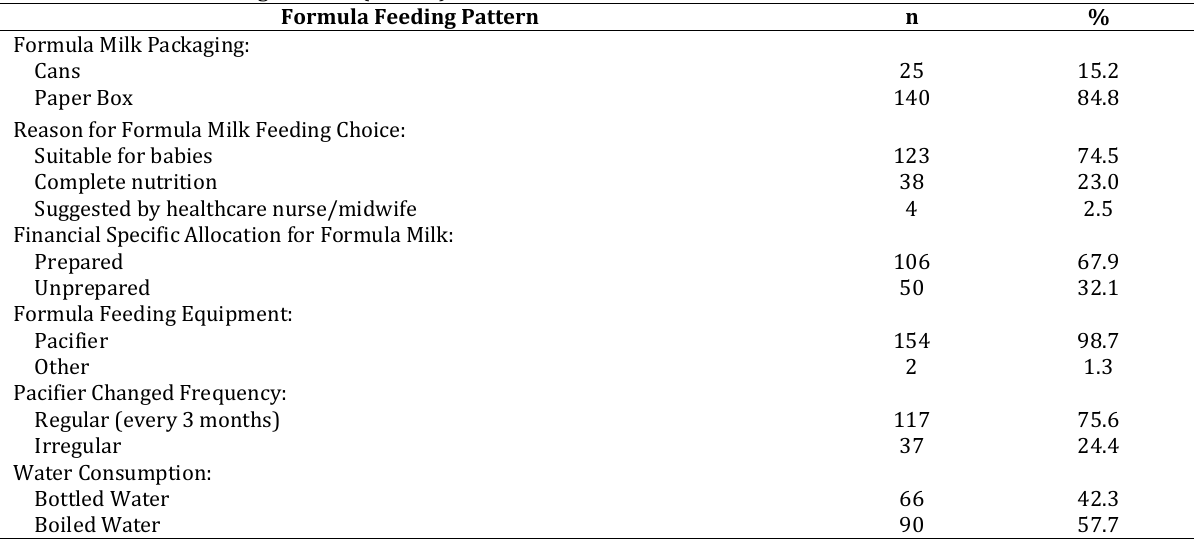
Table 2. Formula Feeding Pattern (n=165) Formula Feeding Pattern